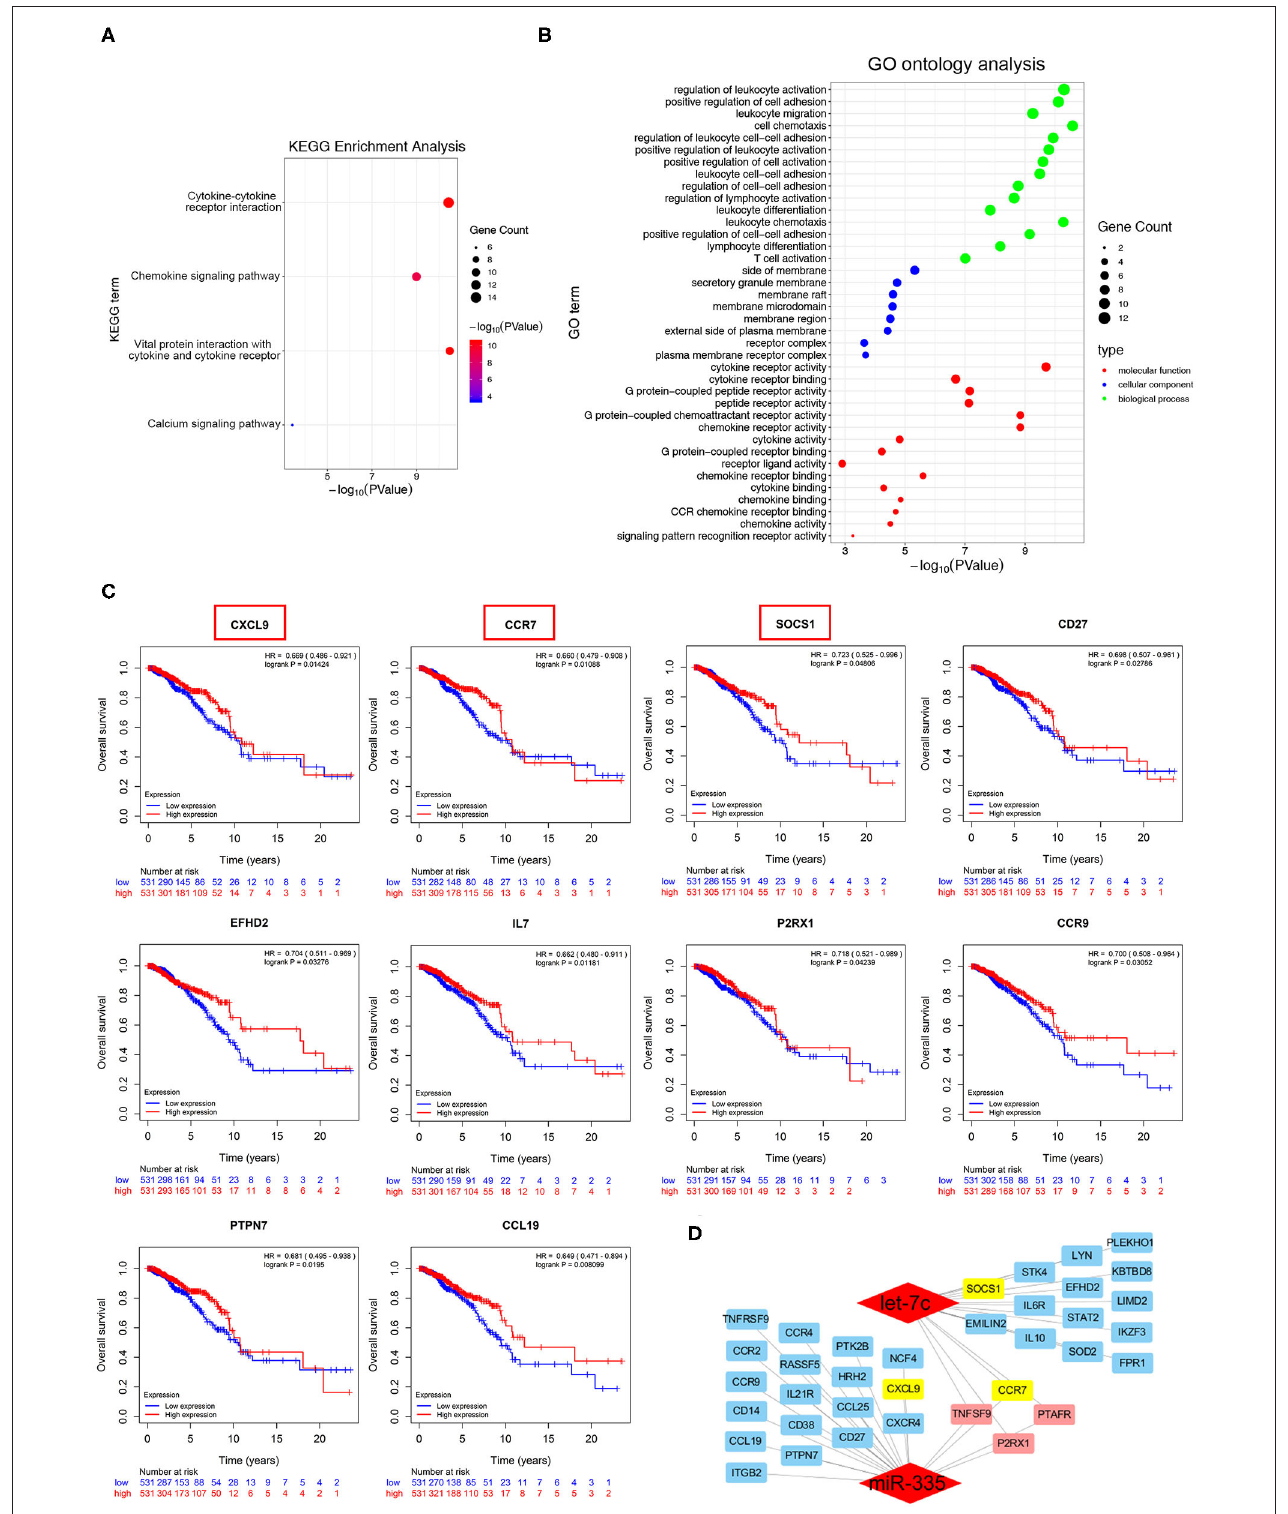
FIGURE 4 | Identification of potential biological roles of the hub genes in the yellow module. (A,B) KEGG pathway enrichment and GO ontology analysis of all genes in the yellow module. (C) Overall survival curves based on hub genes expression of breast cancer patients in TCGA database. (D) Sub-network of candidate target genes and the corresponding upstream miRNAs.